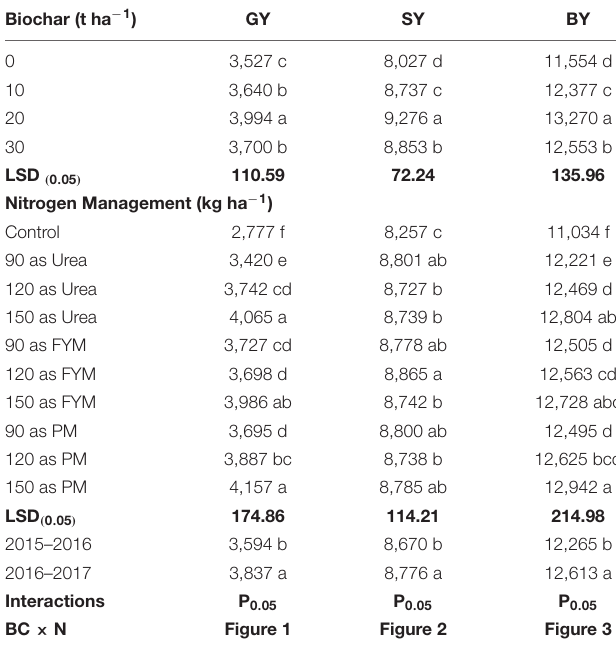
TABLE 1 | Effect of biochar and n levels applied from different sources on wheat grain, straw, and biological yield (kg ha − 1 ).